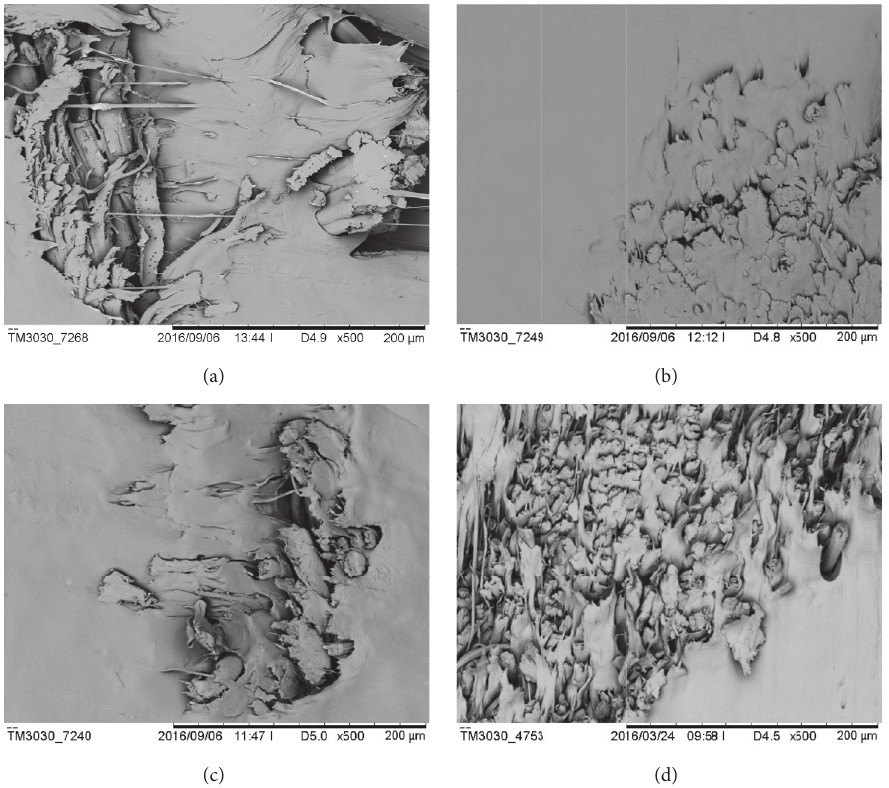
Figure 8: SEM images of the cross-section surface of (a) UJBC, (b) JCC, (c) BCC, and (d) JBCC at 10 wt% fiber loading.